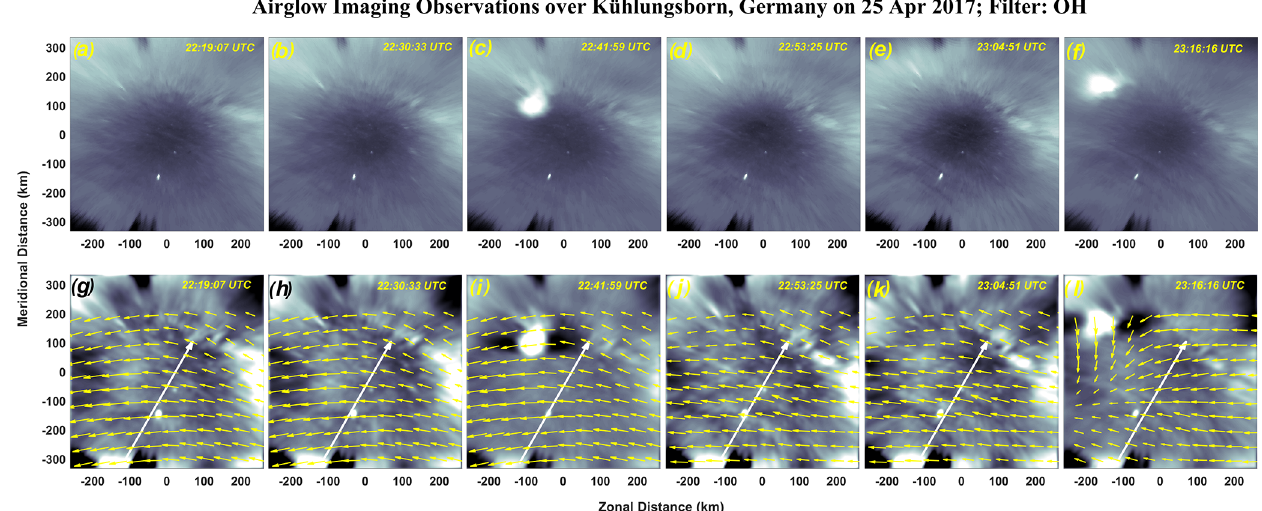
Figure 5. (a–f) Sequence of OH airglow images on 25 April 2017 over northern Germany. (g–l) Corresponding 2D FFT filtered images overlaid on horizontal variation of wind field (yellow arrows) at the emission centroid height (86km) measured by MMARIA. The white arrow denotes the wave